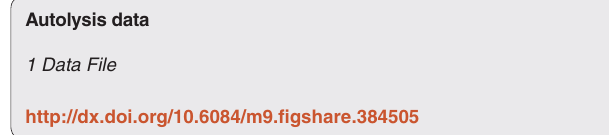
xprG D 1 mutant. Cultures of the xprG1 and xprG2 mutants were observed over a period of eight days to determine whether XprG plays a role in autolysis, which occurs in stationary, submerged cul- tures of A. nidulans after carbon source depletion 45 . The disintegra- medium turbidity due to hyphal fragmentation and accumulation of brown pigment which accompany autolysis occurred more rapidly in the xprG1 gain-of-function mutant. In contrast, mycelial pellets were still present in the cultures of the xprG2 and xprG D 1 mutants (the two xprG - genotypes) after 8 days and there was no evidence of hyphal fragmentation or pigment accumulation (Figure 7). These results indicate that XprG is required for autolysis in response to carbon starvation. Thus, XprG, like Vib-1 of N. crassa has a role in regulating programmed cell death.